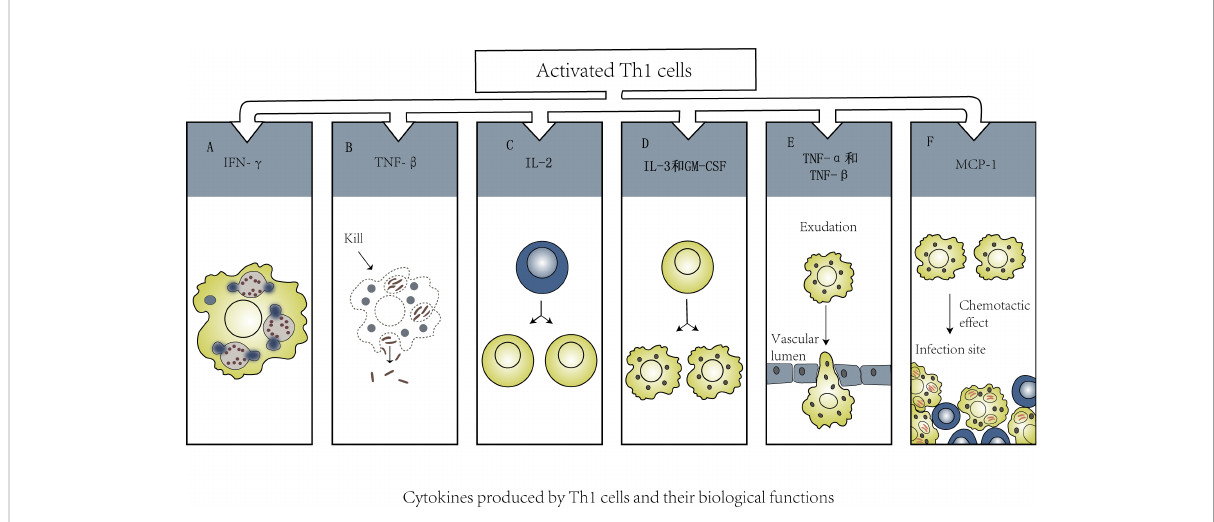
FIGURE 2 (A) . IFN- g ! Activate macrophages and enhance their phagocytosis and killing of intracellular pathogens. (B) . TNF- b ! Kill macrophages with chronic infection. (C) . IL-2 ! Promote activation and proliferation of T cell subsets. (D) . IL-3 and GM-CSF ! Promote the differentiation of bone marrow hematopoietic stem cells into macrophages. (E) . TNF- a 、 TNF- b ! Promote newborn macrophages to in fi ltrate infected tissue through blood vessel wall. (F) . MCP-1 ! Recruit macrophages to the infected focus to exert its